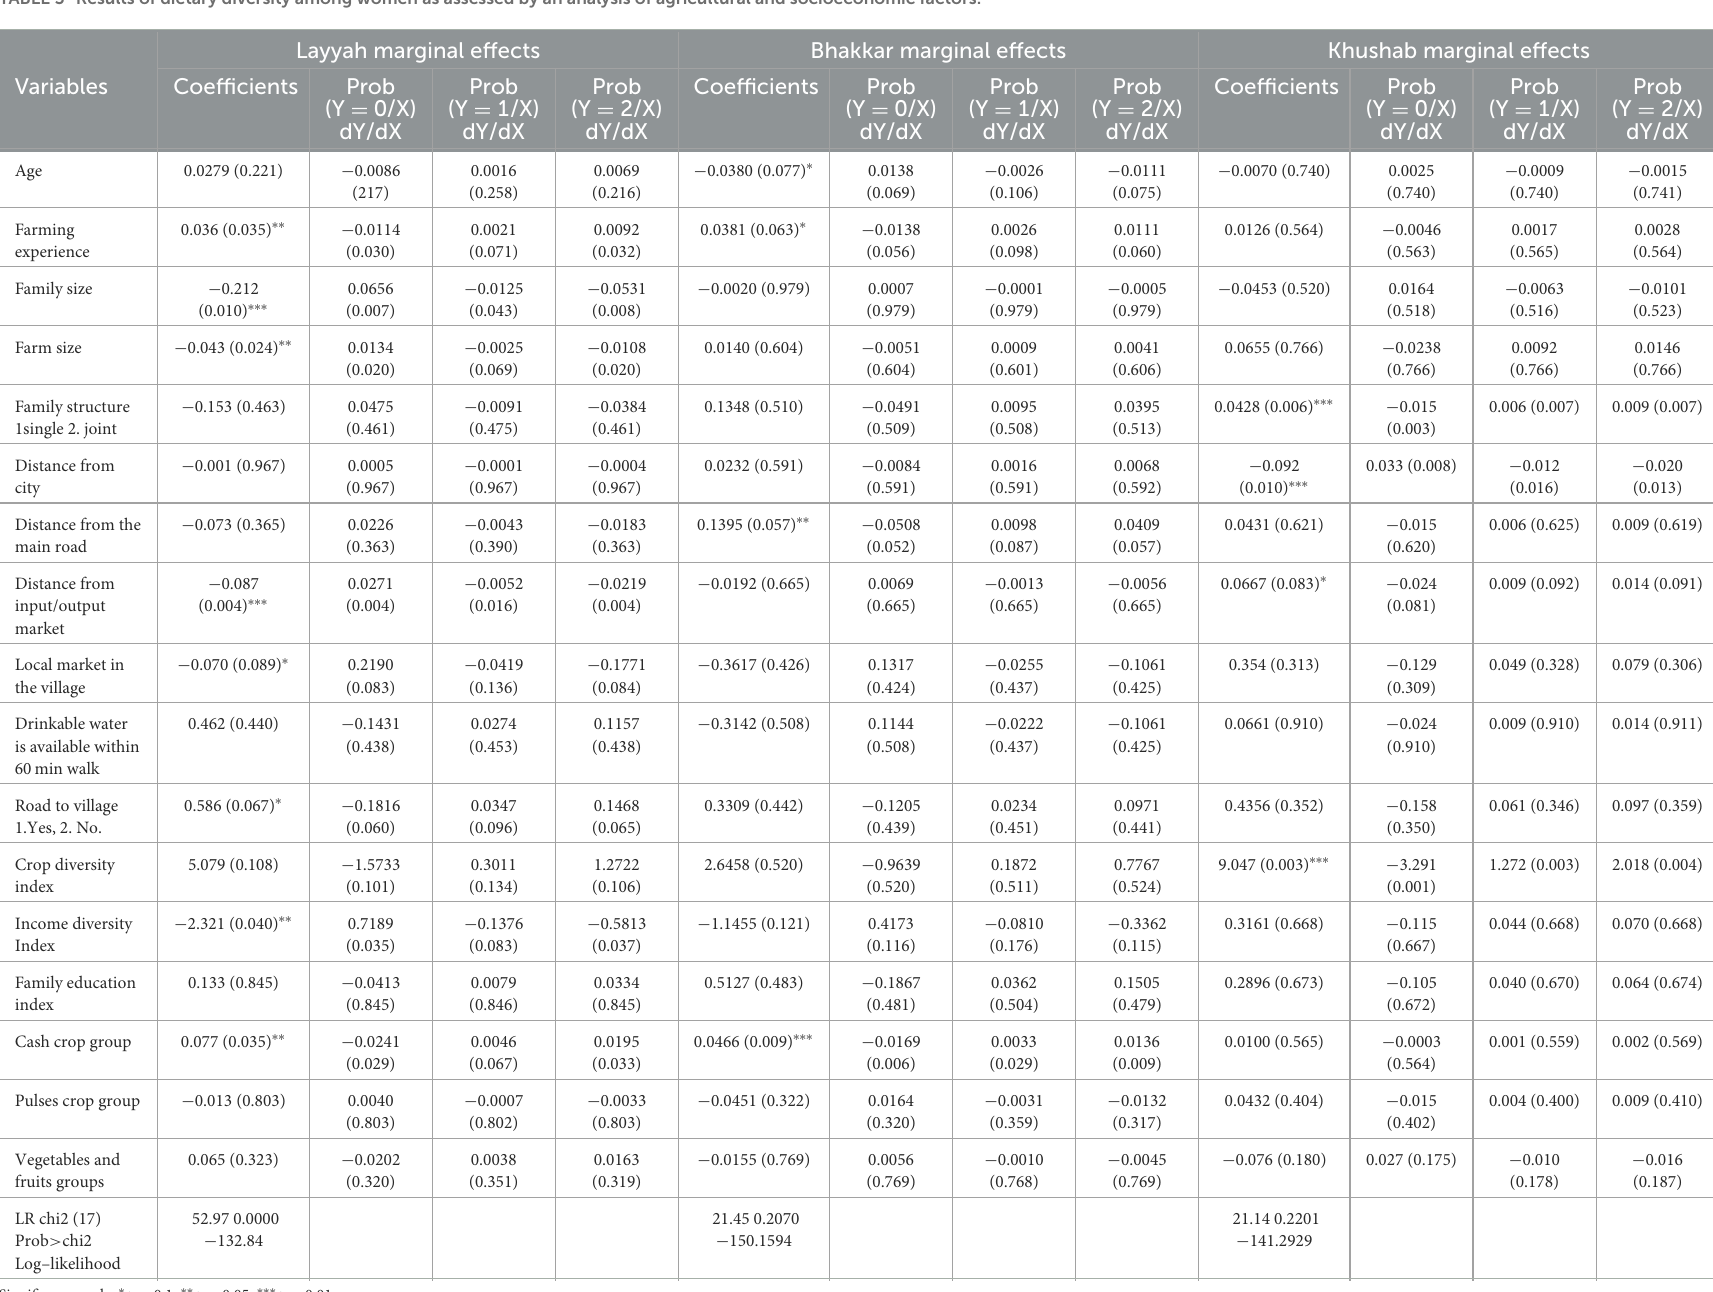
TABLE 3 Results of dietary diversity among women as assessed by an analysis of agricultural and socioeconomic